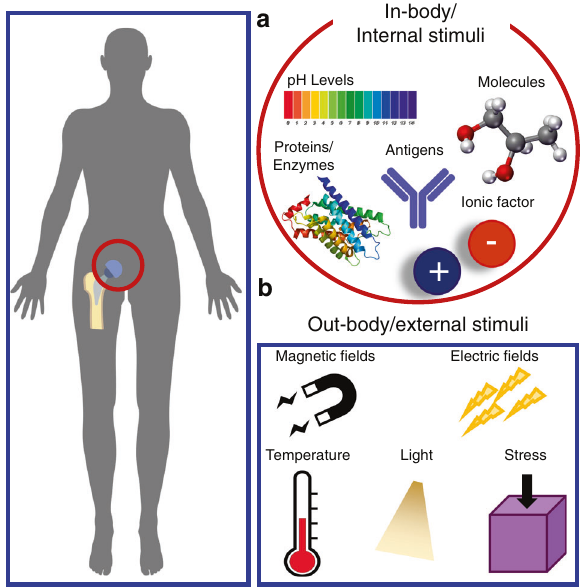
Fig. 3 Different types of internal and external stimuli used to enable diverse biofunctionalities of biomaterials. a In-body/internal bioma- terials respond to signals or stimuli in the immediate vicinity of the implanted biomaterial. Some examples of these signals include enzymes, antigens, proteins, pH levels, and ionic factors. b Out- body/external signals are located distally from the biomaterial (e.g., outside the body) and could include electromagnetic fi elds, mechanical stresses, or temperature changes. Some signals, includ- ing temperature, can be found both in-body and